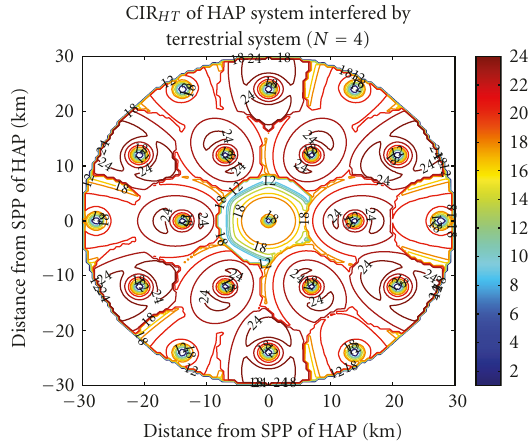
Figure 14: UL CIR value of HAP system (CIR HT ) interfered by the terrestrial system.